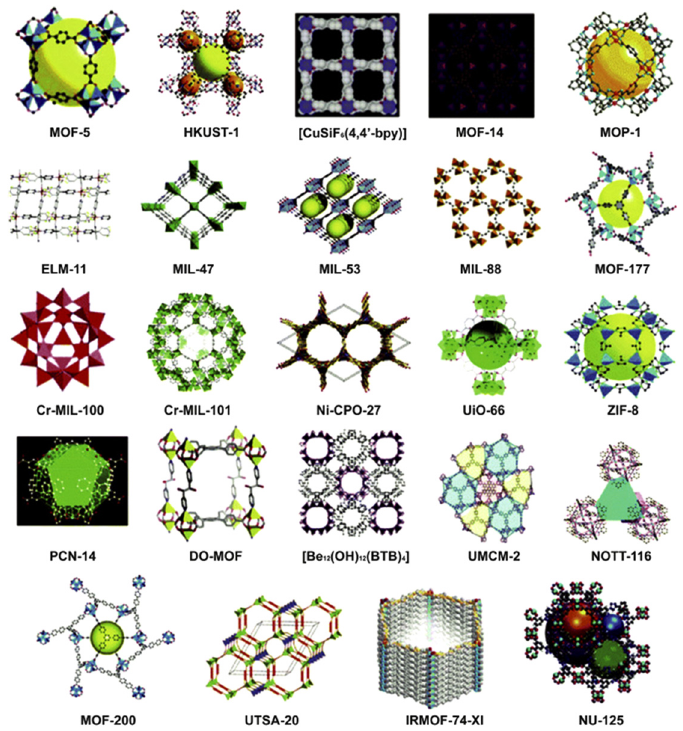
Figure 3. Various types of MOFs synthesized by different research groups [9]. Reproduced with permission.